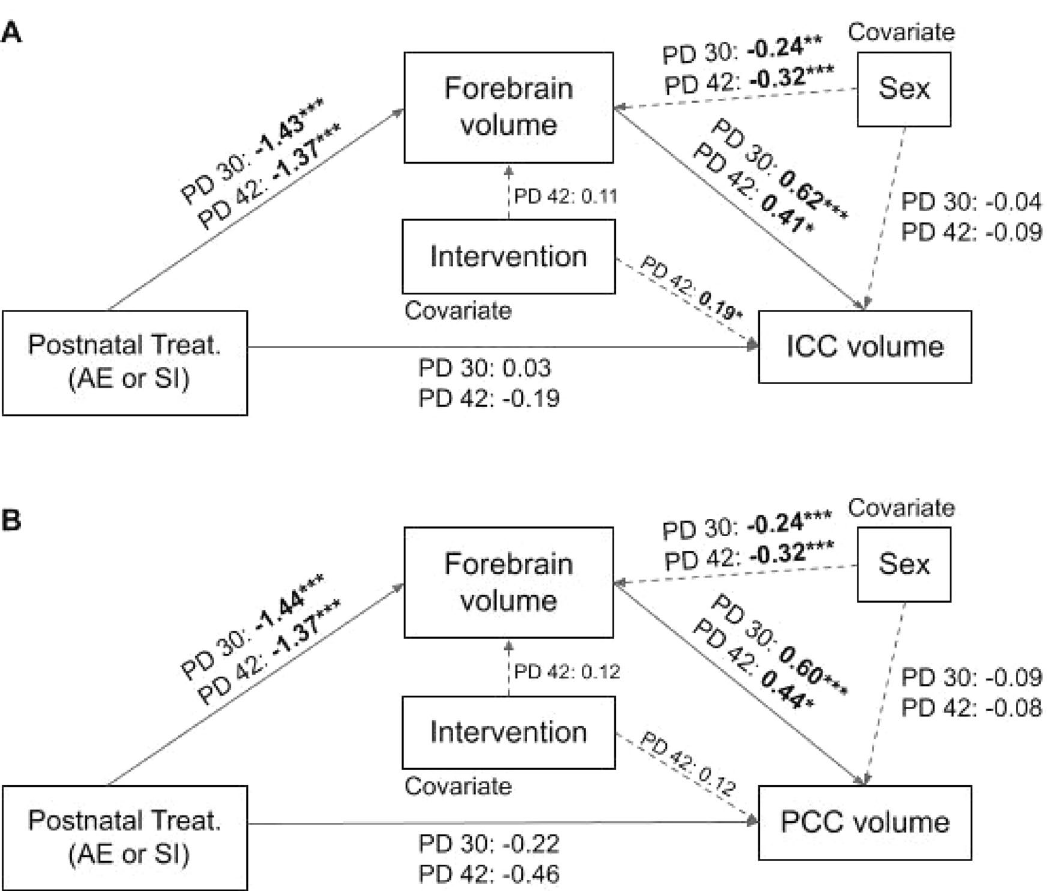
Figure 5. Statistical models for the regression-based mediation analyses which illustrate that postnatal treatment indirectly affects ICC ( A ) and PCC ( B ) volumes through lasting alterations to forebrain volume on PD30 and 42. All values represent standardized regression coefficients. Bolded coefficients indicate statistically significant relationships. Factors: postnatal treatment, ICC/PCC volume; Mediator: Forebrain volume; Covariates: sex and intervention group. N = 80, *** p < .0001, ** p < .01, * p <